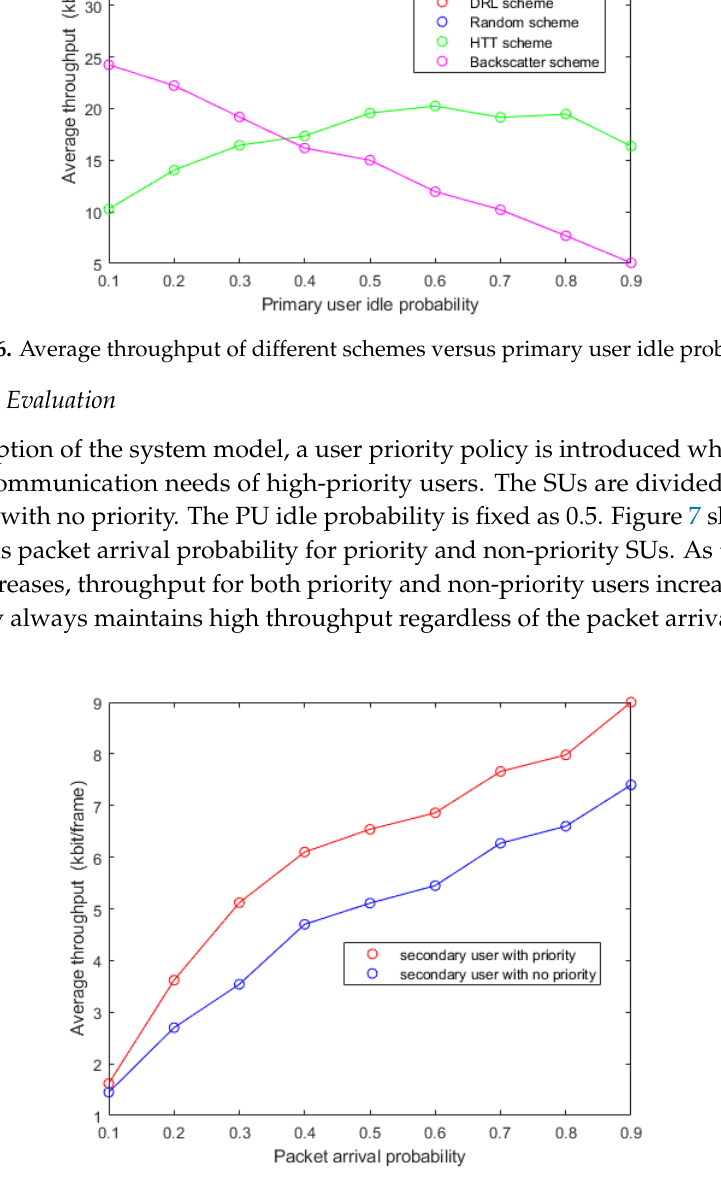
Figure 7. Average throughput of priority strategy versus packet arrival